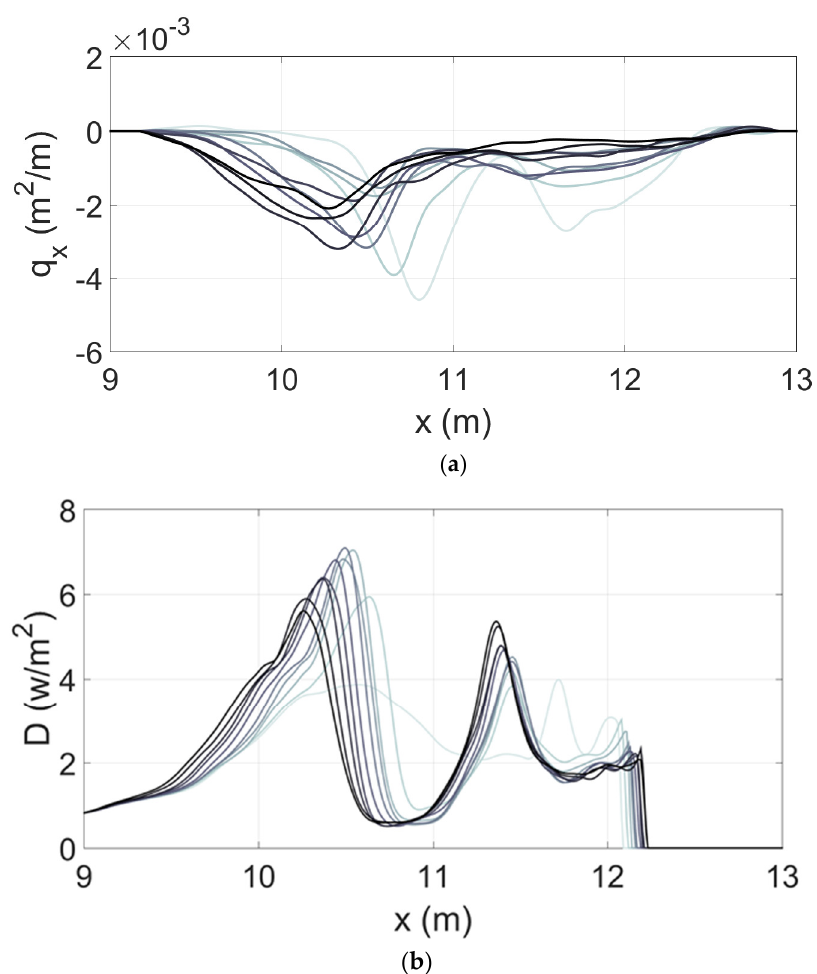
Figure 3. ( a ). Corresponding series of local sediment transport for Figure 2, in chronological order from light grey (start) to dark grey (finish). ( b ) Wave energy dissipation for the beach profiles presented in Figure 2, in chronological order from light grey (start) to dark grey (finish).